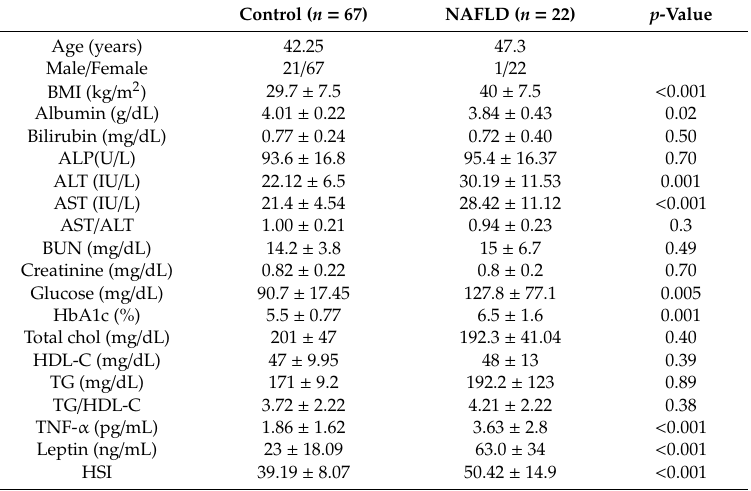
Table 1. Demographics and standard plasma metrics expressed as average ± standard